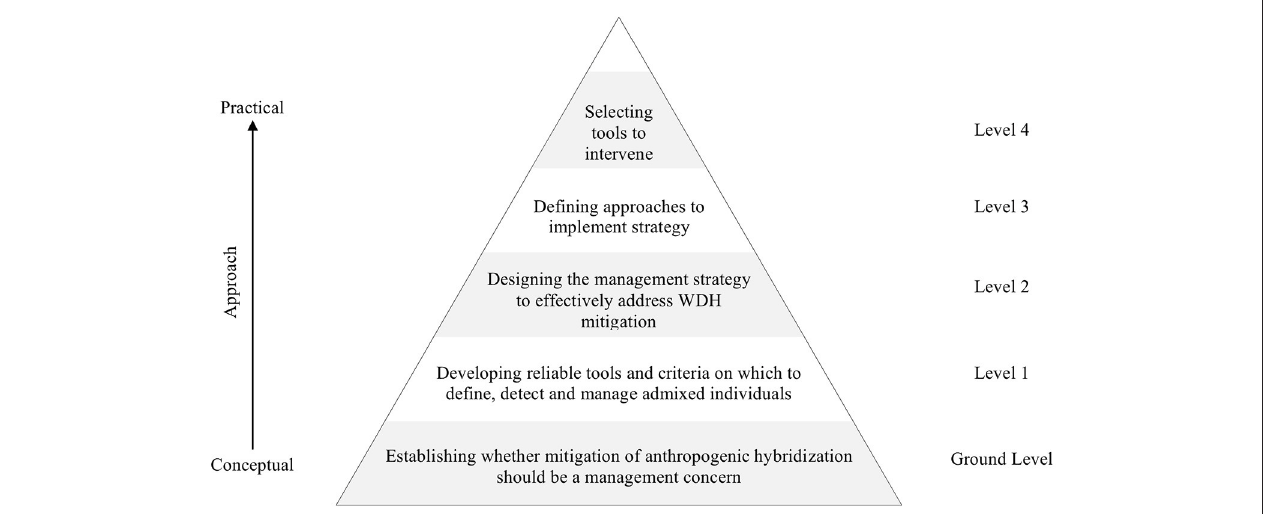
FIGURE 2 | Hierarchical structure of the questions used in a Delphi survey to assess the degree of consensus among 42 European experts in dealing with management of wolf × dog hybridization. The questions in this survey were ranked according to the type of approach they addressed, from conceptual to practical, aiming to investigate at which level disagreement occurred. At the Ground Level is found Q1. At Level 1 are found questions 2–11. At Level 2 are found questions 12–15. At Level 3 are found questions 16–26. At Level 4 are found questions 27–30. See Supplementary Materials for the questions.